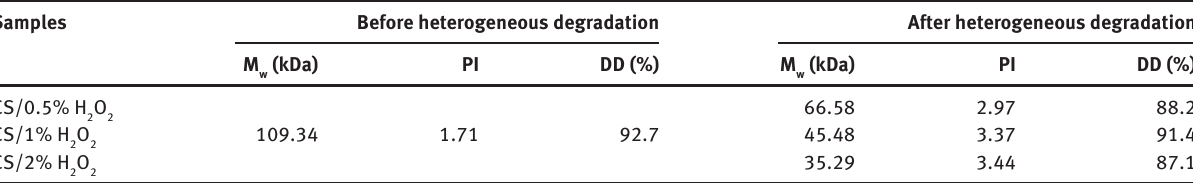
O on M and DD of chitosan before irradiation. 2 2 w